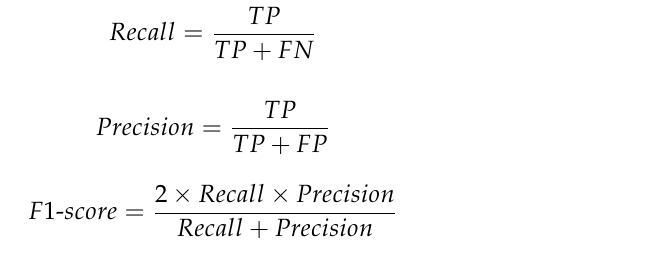
Table 6. Basic terms and critical indicators of two trained